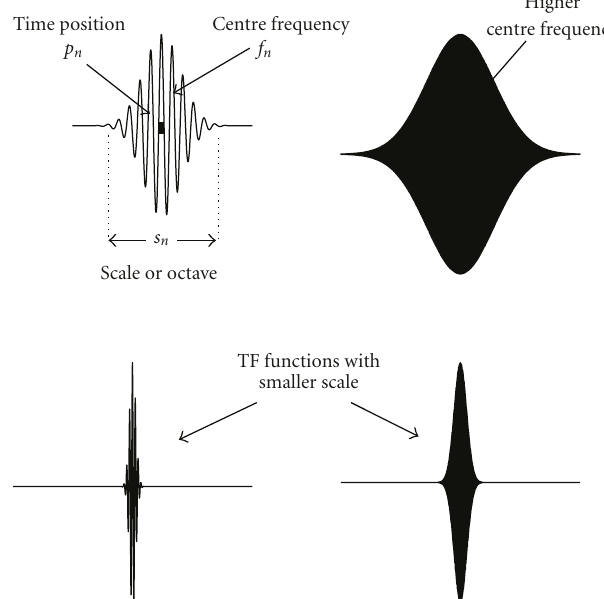
Figure 1: Gaussian TF function with di ff erent scale, and modulation